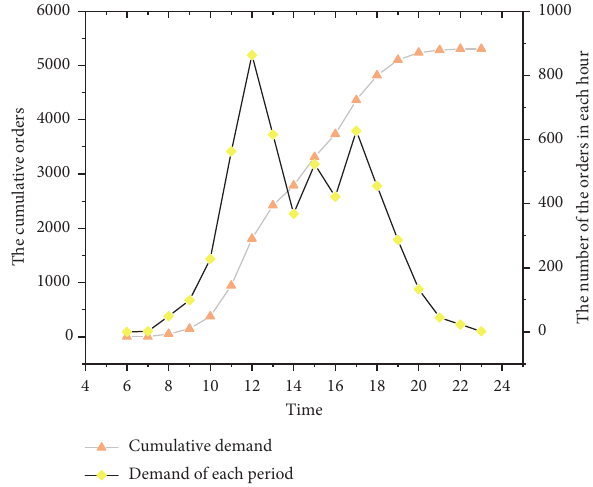
Figure 5: The statistics chart of the orders in January 2017.